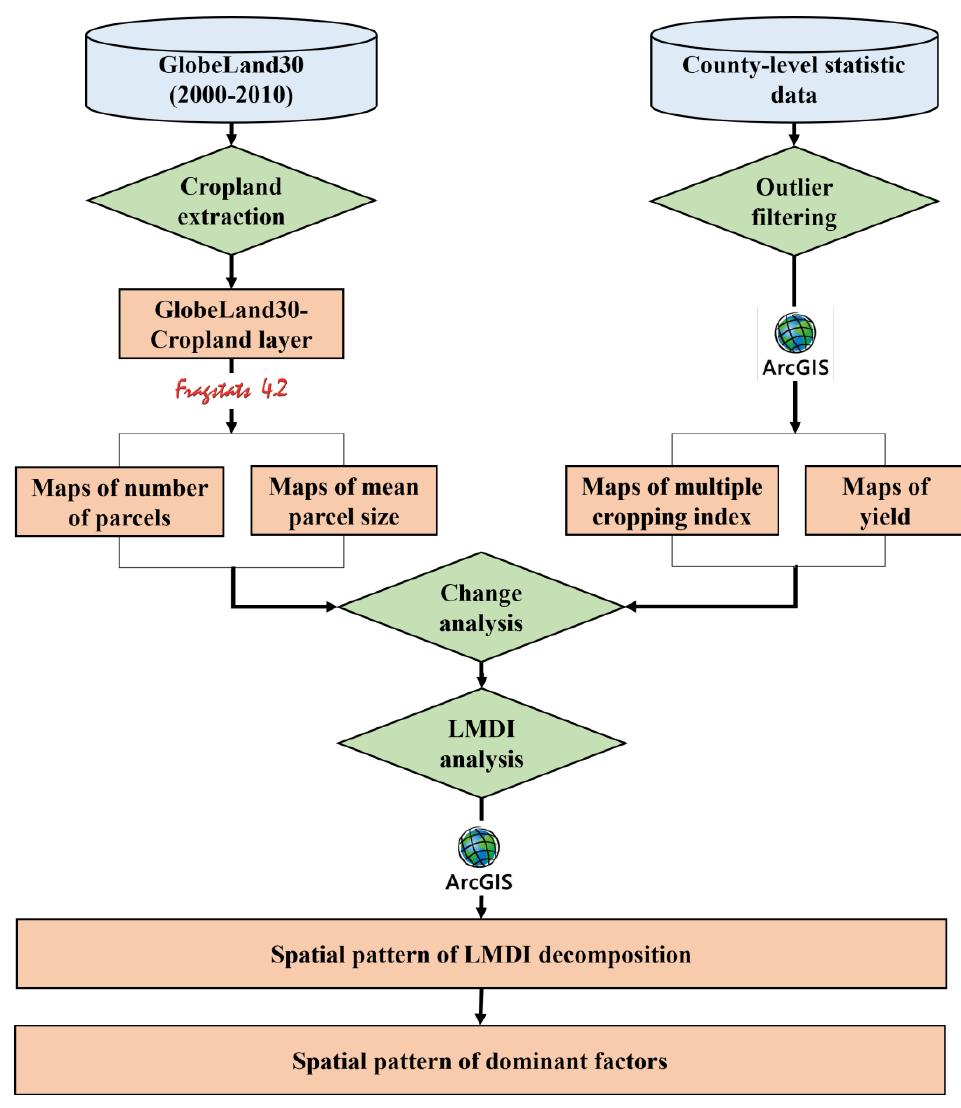
Figure 3. Flowchart of the methodological approach. Our study approach comprises the following steps: (1) Extracting cropland layer from GlobeLand30 and calculating landscape metrics using FRAGSTATS 4.2; (2) Calculating crop yield and multiple cropping index at the county scale based on statistical data; (3) Quantifying the contributions of all four indicators to crop production change, including food, feed, and fiber crops (cylinders = datasets, diamonds = data-processing and method, rectangular = results and maps).